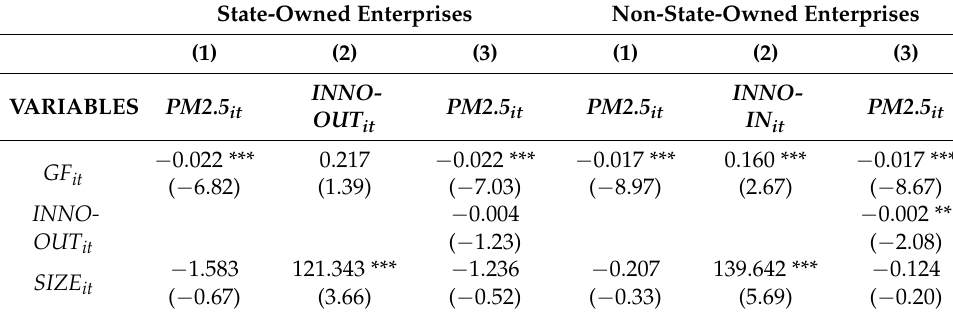
Table 6. Regression results of the nature of property